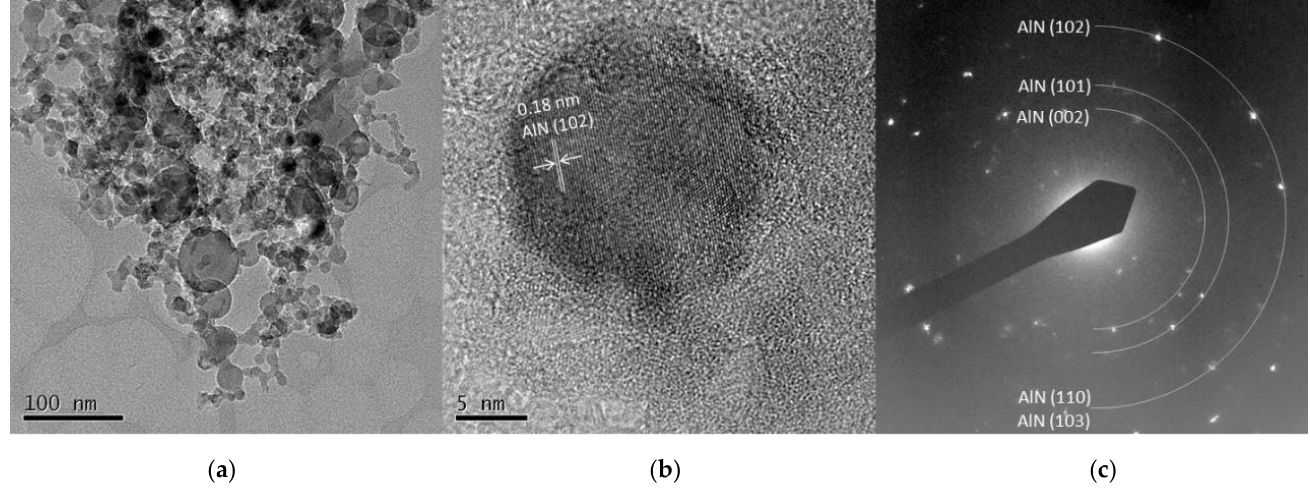
Figure 7. TEM images of Al 5 A particles ( a ) low resolution image; ( b ) high resolution image; ( c ) SAED pattern